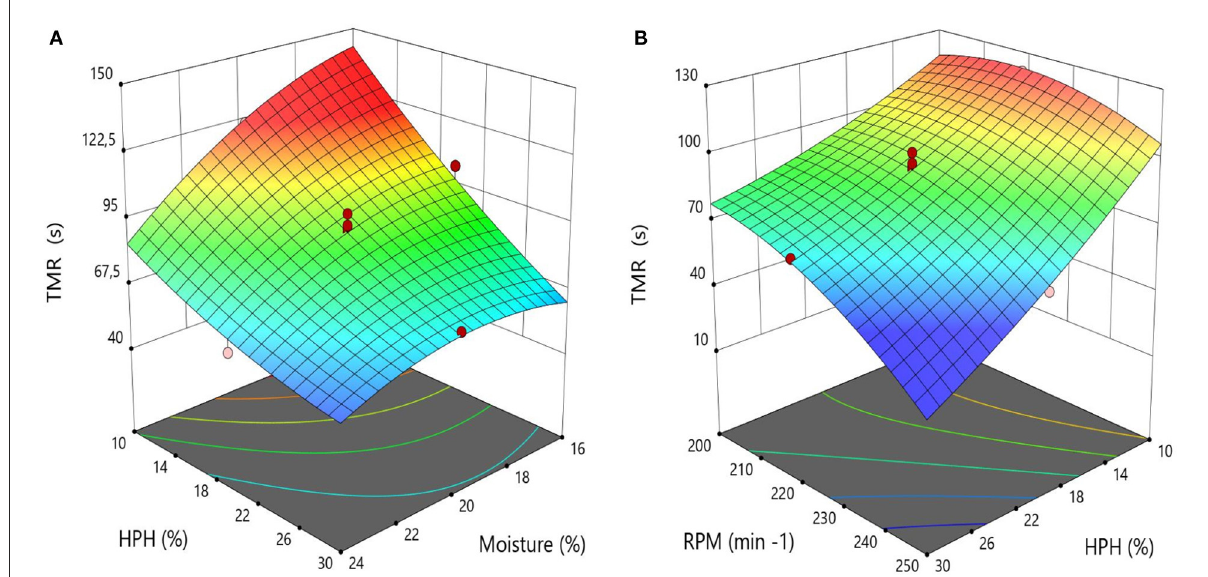
FIGURE4 Effect of HPH, moisture and temperature on density. (A) Moisture vs. HPH (temperature 125 ◦ C and screw speed 220 RPM). (B) HPH vs. temperature (screw speed 220 RPM and moisture 20%).